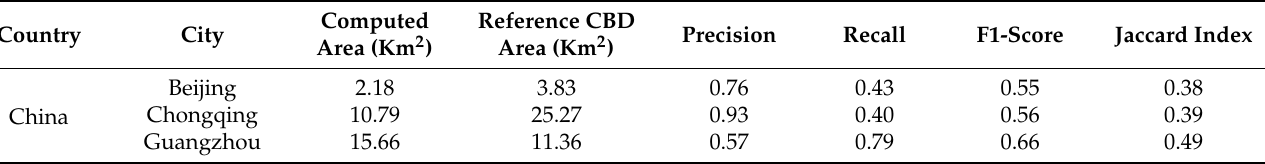
Table 6. Evaluation of urban CBD boundaries in China and the